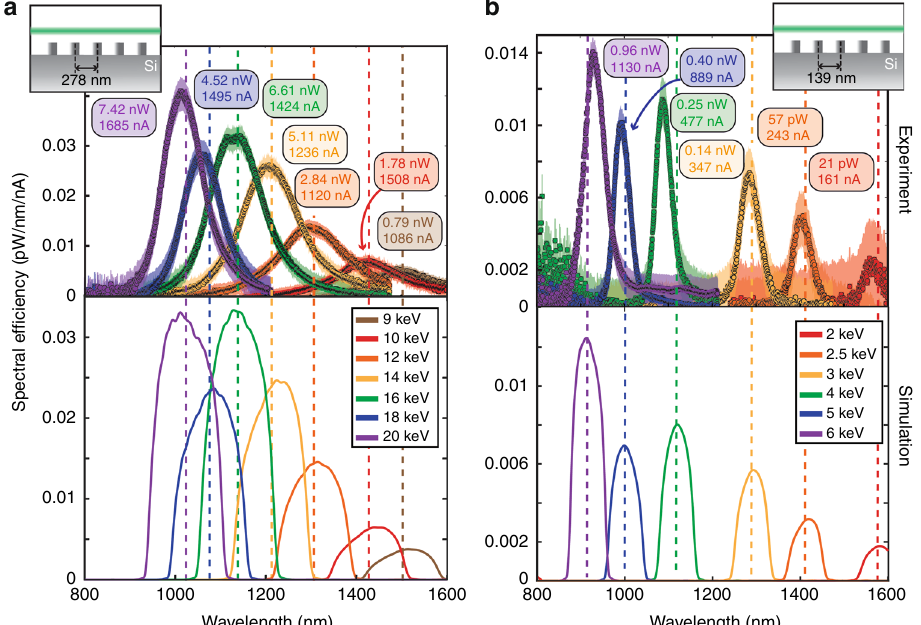
Fig. 2 Observation of tunable radiation from silicon in the 800 – 1600 nm window. Experimental (top) and simulated (bottom) spectral ef fi ciencies recorded for various kinetic energies ( a ) (9 – 20 keV) from 278 nm-period gratings and ( b ) (2 – 6 keV) from 139 nm-period gratings. The incident electron current and measured output powers are reported in the colored boxes for each measurement. Dashed lines correspond to the predicted output wavelength at normal emission direction from the SP energy-angle equation. Optical and quantum ef fi ciencies are reported in the SI, section I. Error bars (shaded area) are estimated from the standard deviation of the background signal